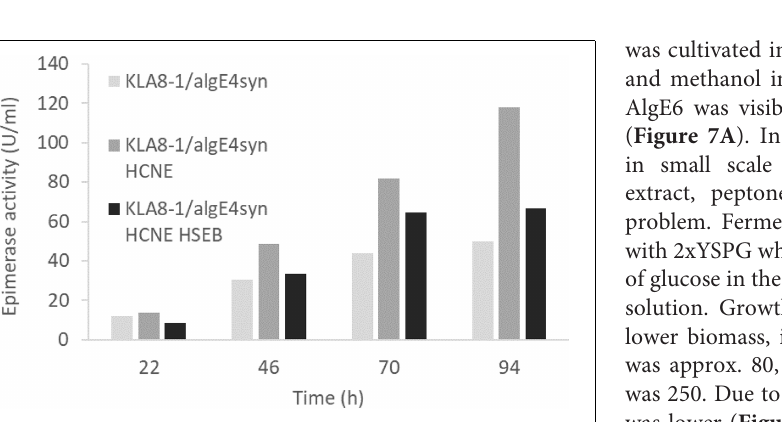
FIGURE 6 | Effect of increased calnexin (HpCNE) and SEB1 (HpSEB) gene dosage on the production of AlgE4 in H. polymorpha . Specific AlgE4 epimerase activity (U/ml culture) obtained with KLA8-1/algE4syn, KLA8-1/algE4syn HCNE, and KLA8-1/algE4syn HCNE HSEB during the fermentation process with samples taken at 22, 46, 70, and 94 h. Strains were cultivated in HCD (37 ◦ C, pH 5.5) and with feeding solutions composed of glucose (60%) and methanol (10% of